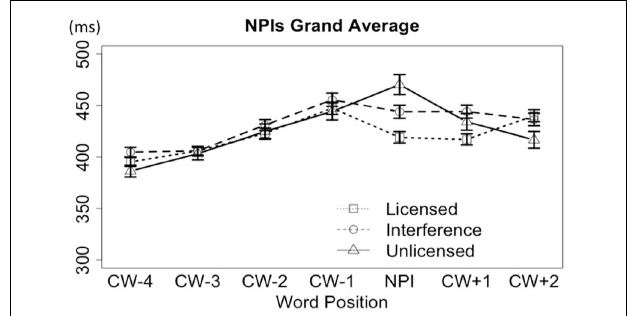
collapsing the licensors “ no ” and “ only.